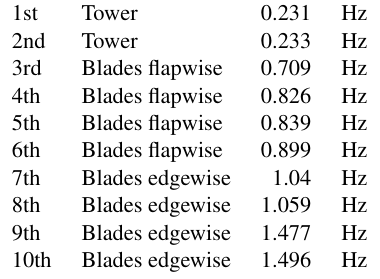
Table 3. Natural frequencies of the